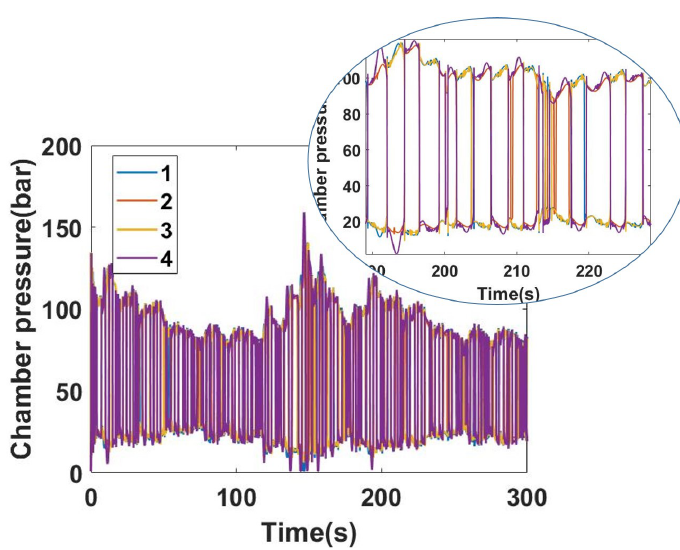
Figure 20. The chamber